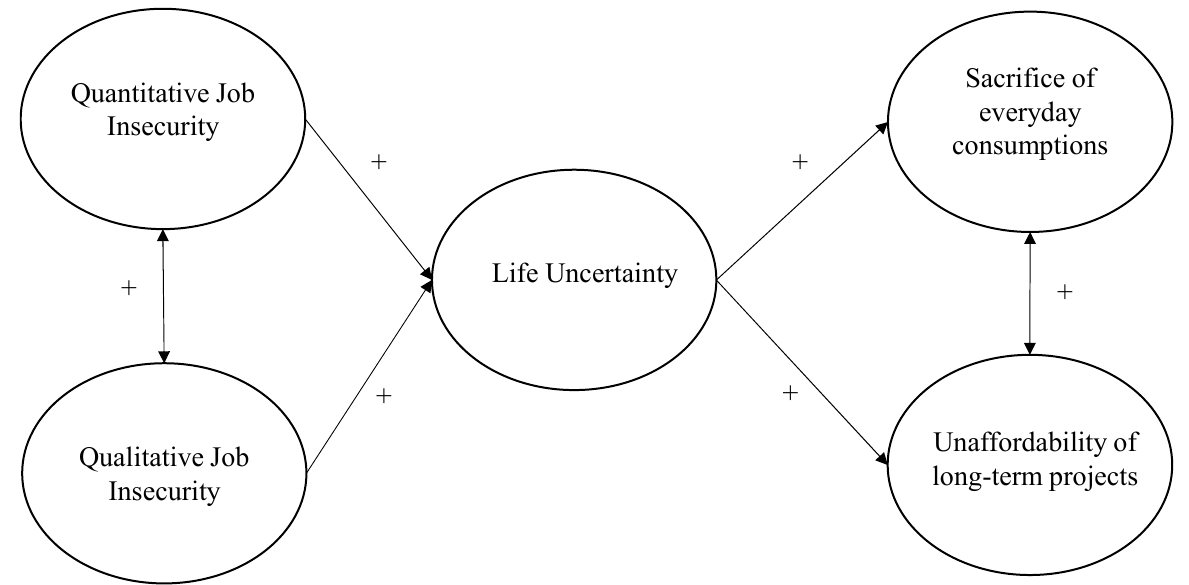
Figure 1. The Theoretical Model.